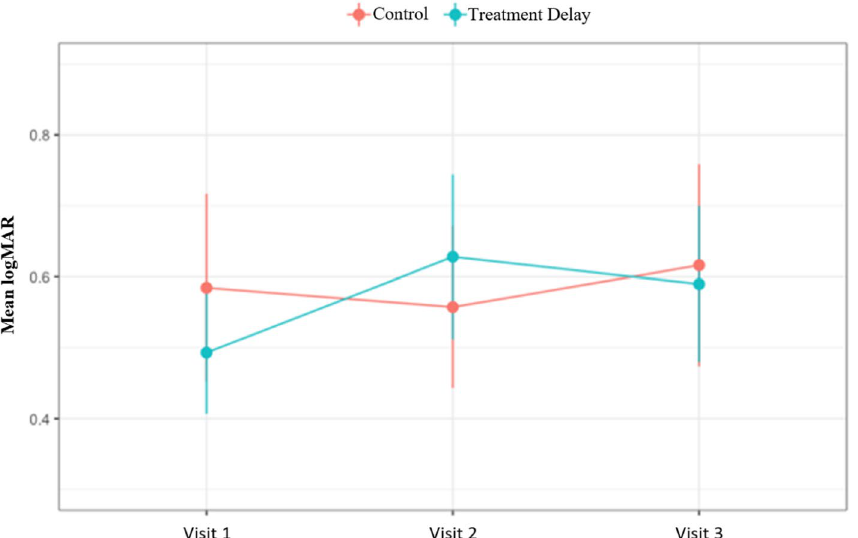
Figure 1. Change in visual acuity over time. Demonstrates the change in visual acuity in logMAR across each visit for both the treatment delay group and the control